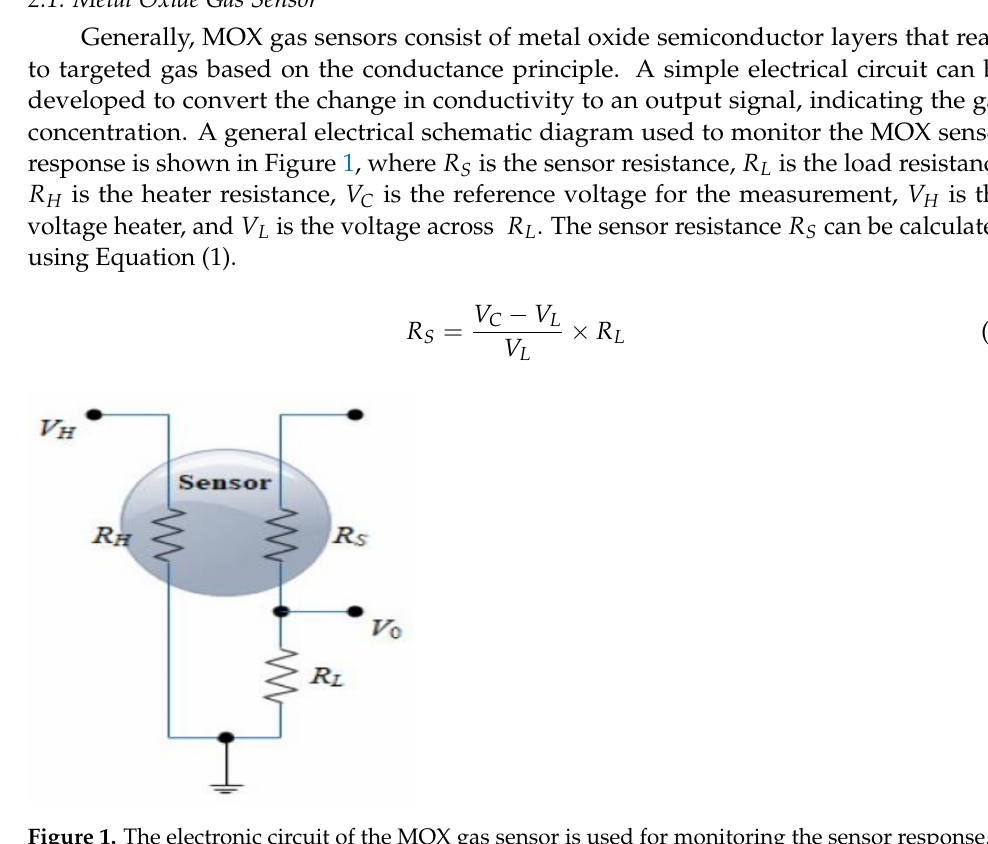
Figure 1. The electronic circuit of the MOX gas sensor is used for monitoring the sensor